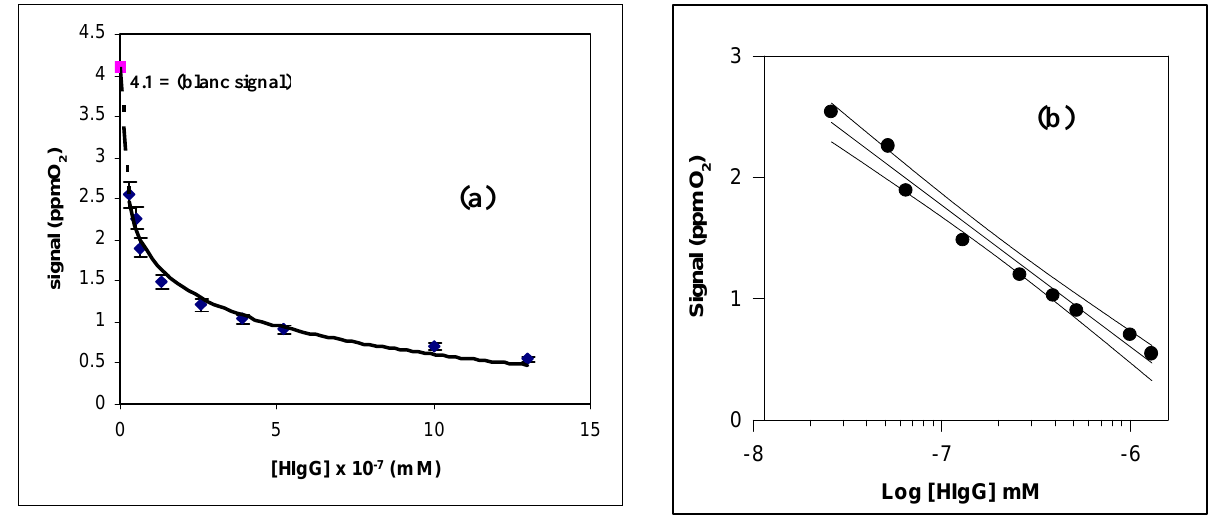
Table 2. Analytical characterization of new immunosensor method for HIgG determination, using two different membranes for antibody immobilization. Operating conditions: Buffer Determination HIgG by means of new immunosensor, that uses as transducer a tyrosinase enzyme electrode. Geometry of the test: competition for the free in Methods solution anti-HIgG conjugated with the alkaline phosphatase, between the HIgG immobilized on the membrane and HIgG free in